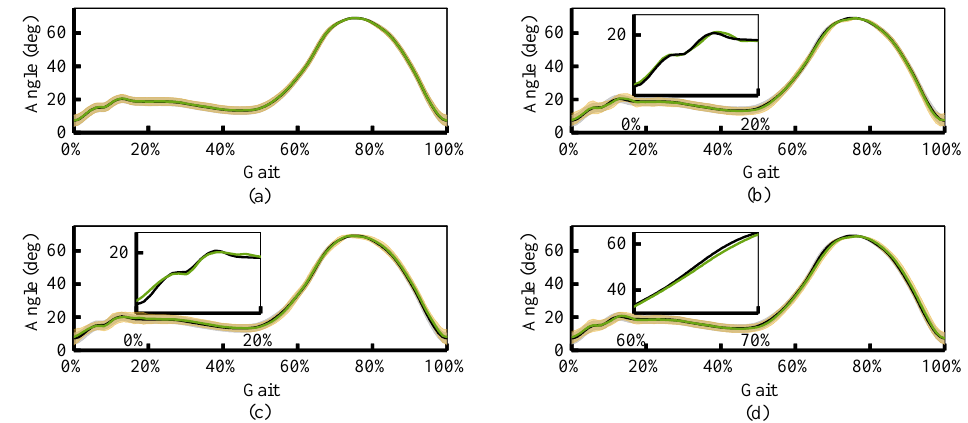
Figure 11. The mean and standard deviation results of four groups of joint trajectory prediction label. The green curve is the prediction result of joint trajectory. The black curve is the actual joint trajectory. All the results are drawn in a gait stride. ( a ) Prediction of joint angle 6.75 ms ahead of time; ( b ) Prediction of joint angle 33.75 ms ahead of time; ( c ) Prediction of joint angle 67.5 ms ahead of time; ( d ) Prediction of joint angle 101.25 ms ahead of